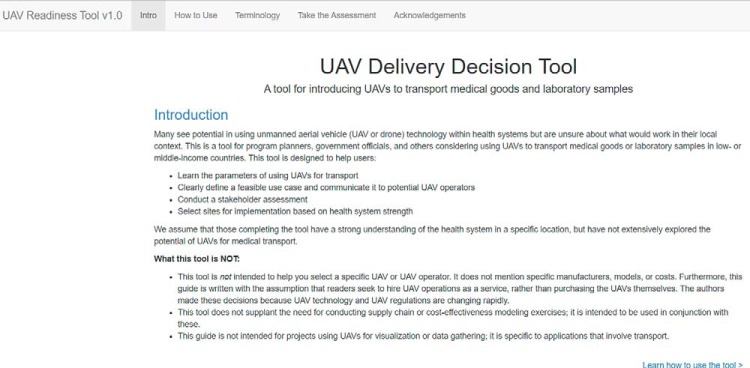
Screenshot of UAV Delivery Decision Tool. © 2019/FHI 360